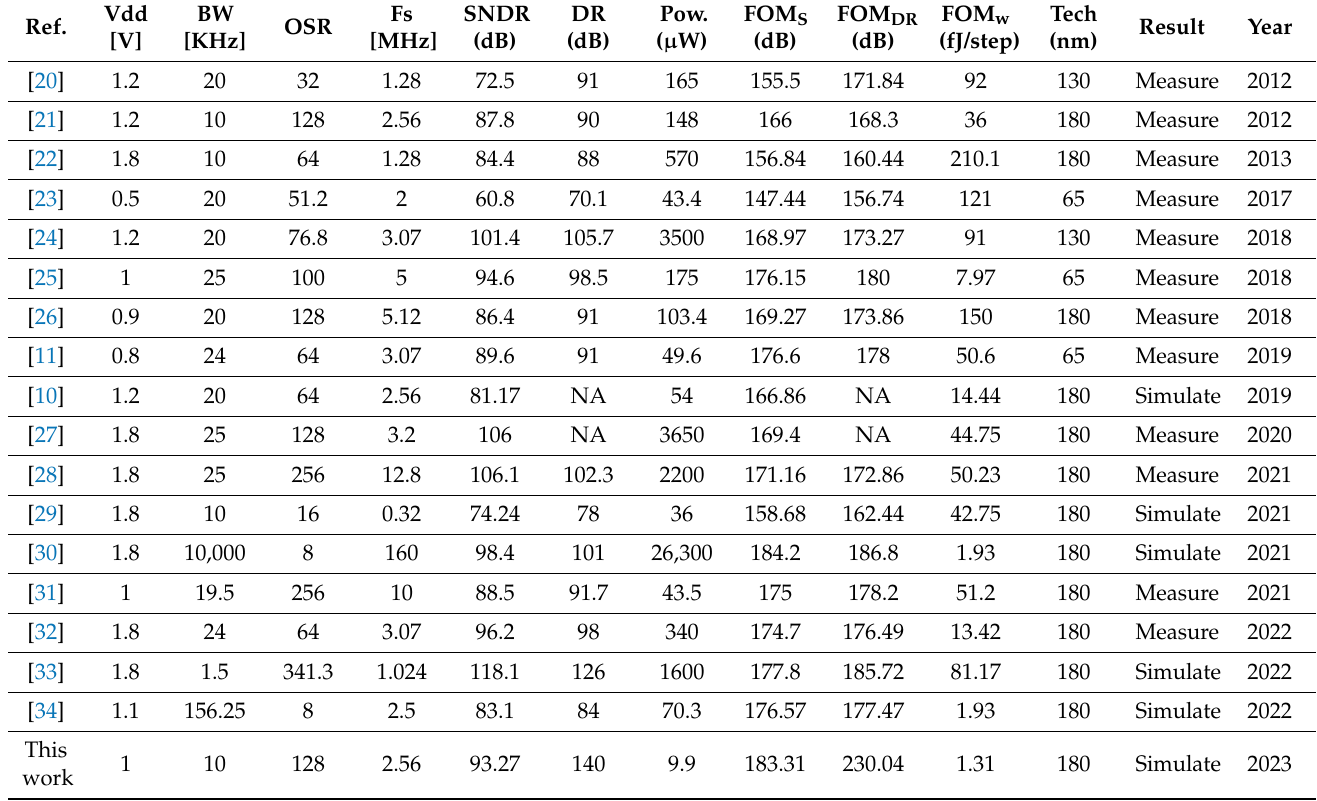
Table 10. The performance comparison of delta–sigma